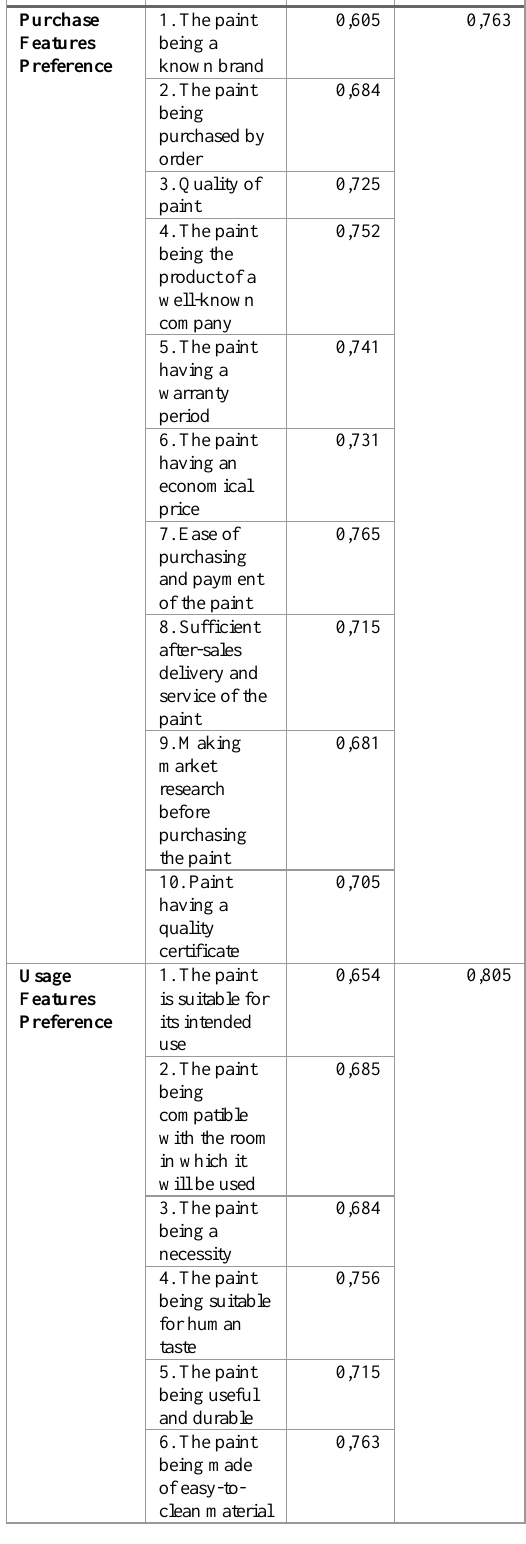
Table 7: Reliability of the Scale and Factor Analysis Purchase Features